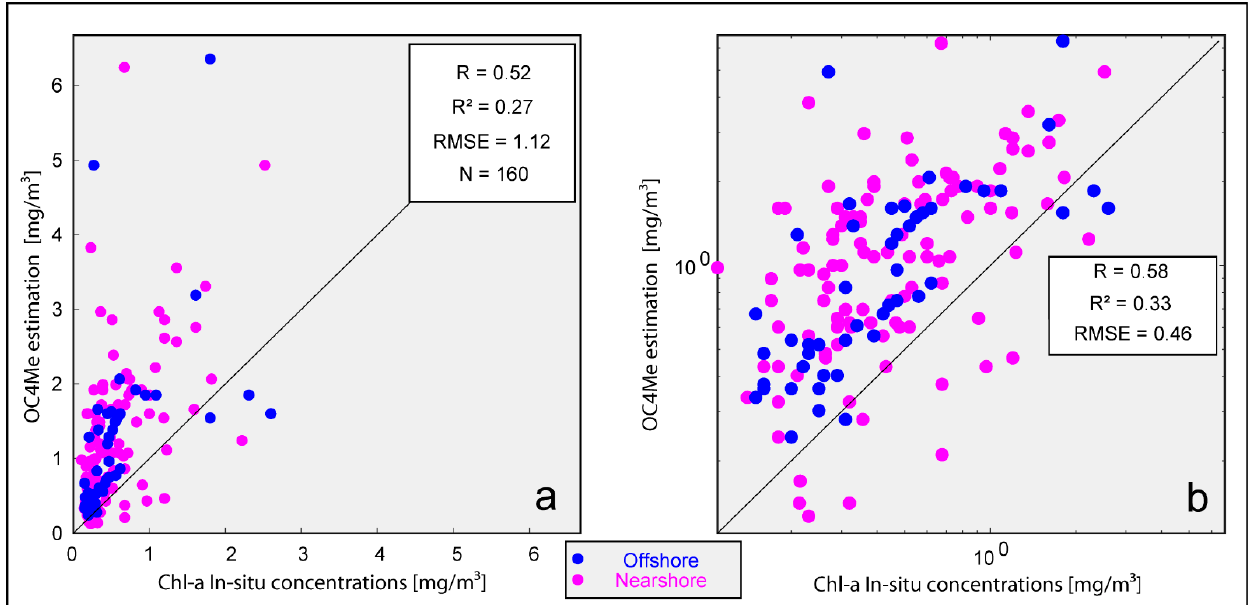
Figure 6. ( a ) Scatter plot of in-situ Chl- a concentration versus OC4Me Chl- a estimates. ( b ) Same in logarithmic scale. The offshore and nearshore stations (Figure 1) are plotted in blue and magenta colors, respectively.